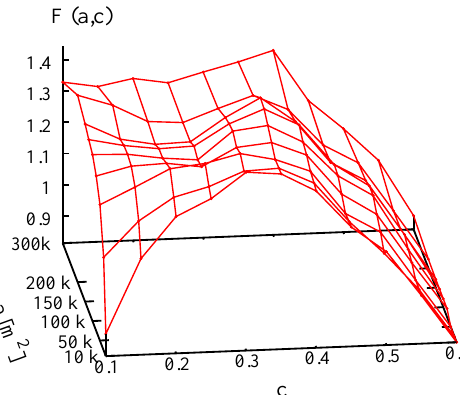
Figure 9. Segmentation objective function values (Eq. 3) calculated for 99 SU partitions obtained using different combinations of the a and c